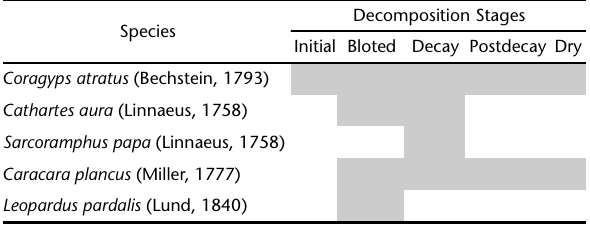
Table I. Species of vertebrates visiting the pigs carcasses at the different stages of decomposition.